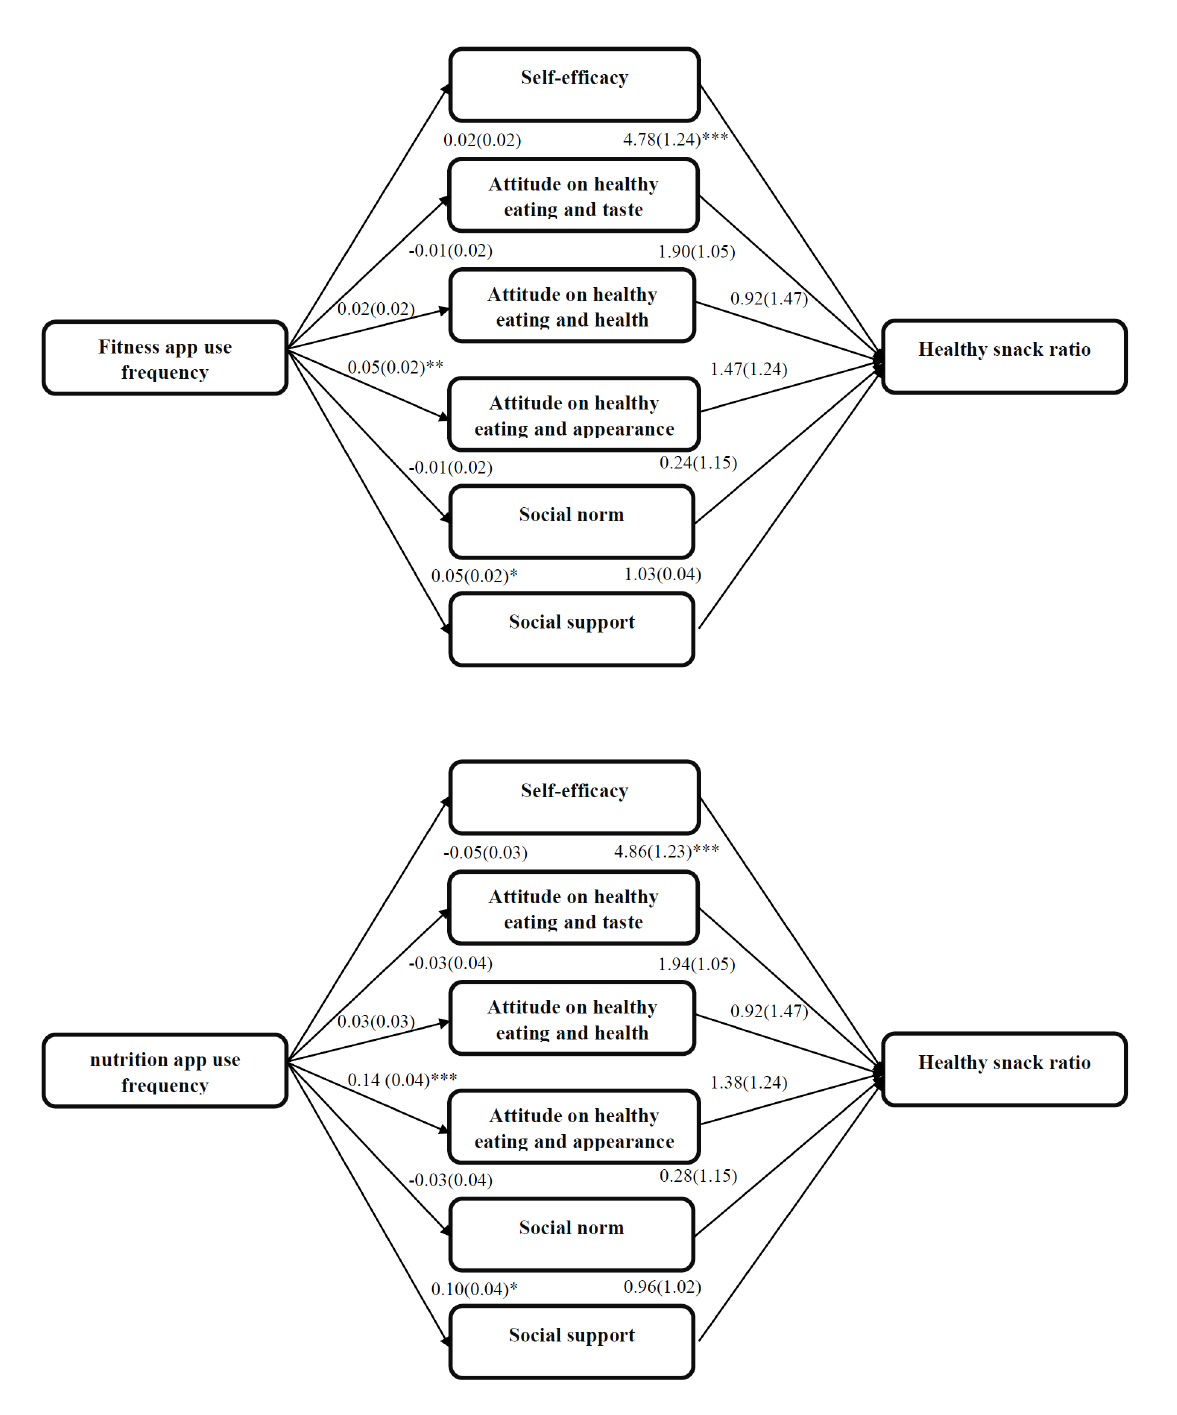
Figure 3. Multiple mediation healthy snack ratio. Analyses controlled for sex and education type; * P <.05, ** P <.01, *** P